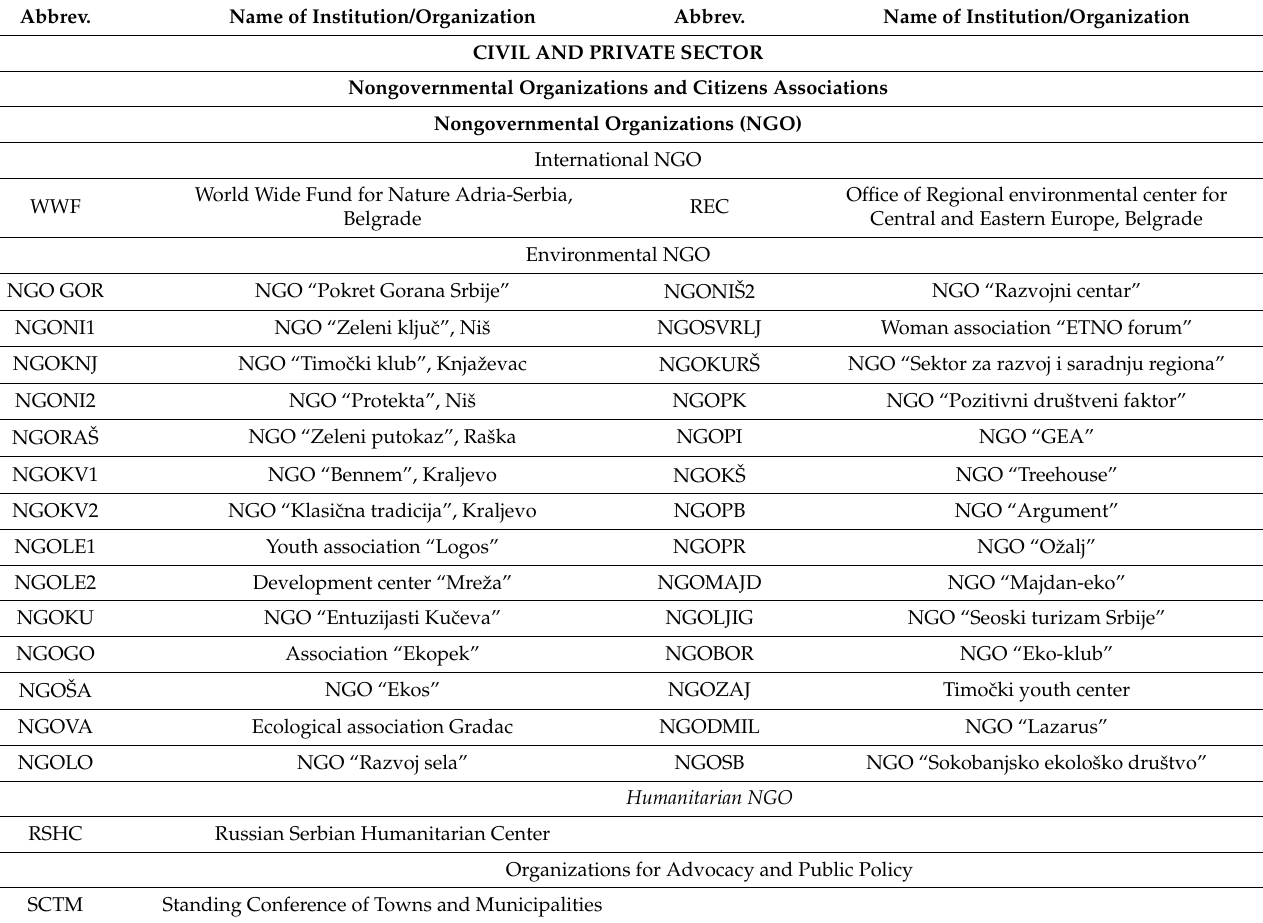
Table A4. Overview of civil sector stakeholders in collaboration network per sector affiliation.